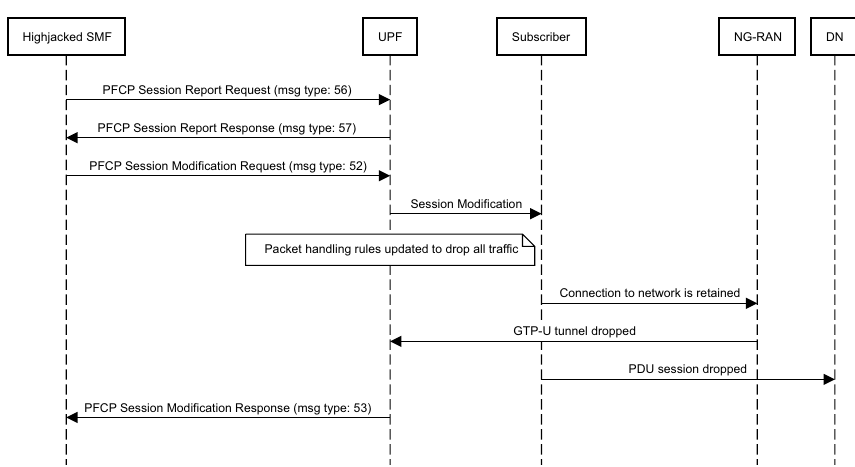
Fig. 4 Session Modification DoS attack: A UML sequence diagram for the session modification